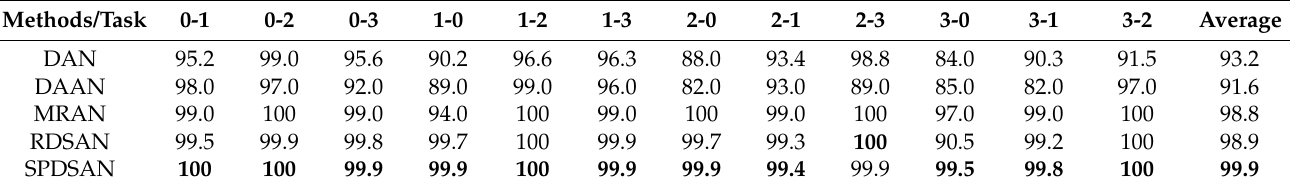
Table 3. Diagnostic accuracy of different models